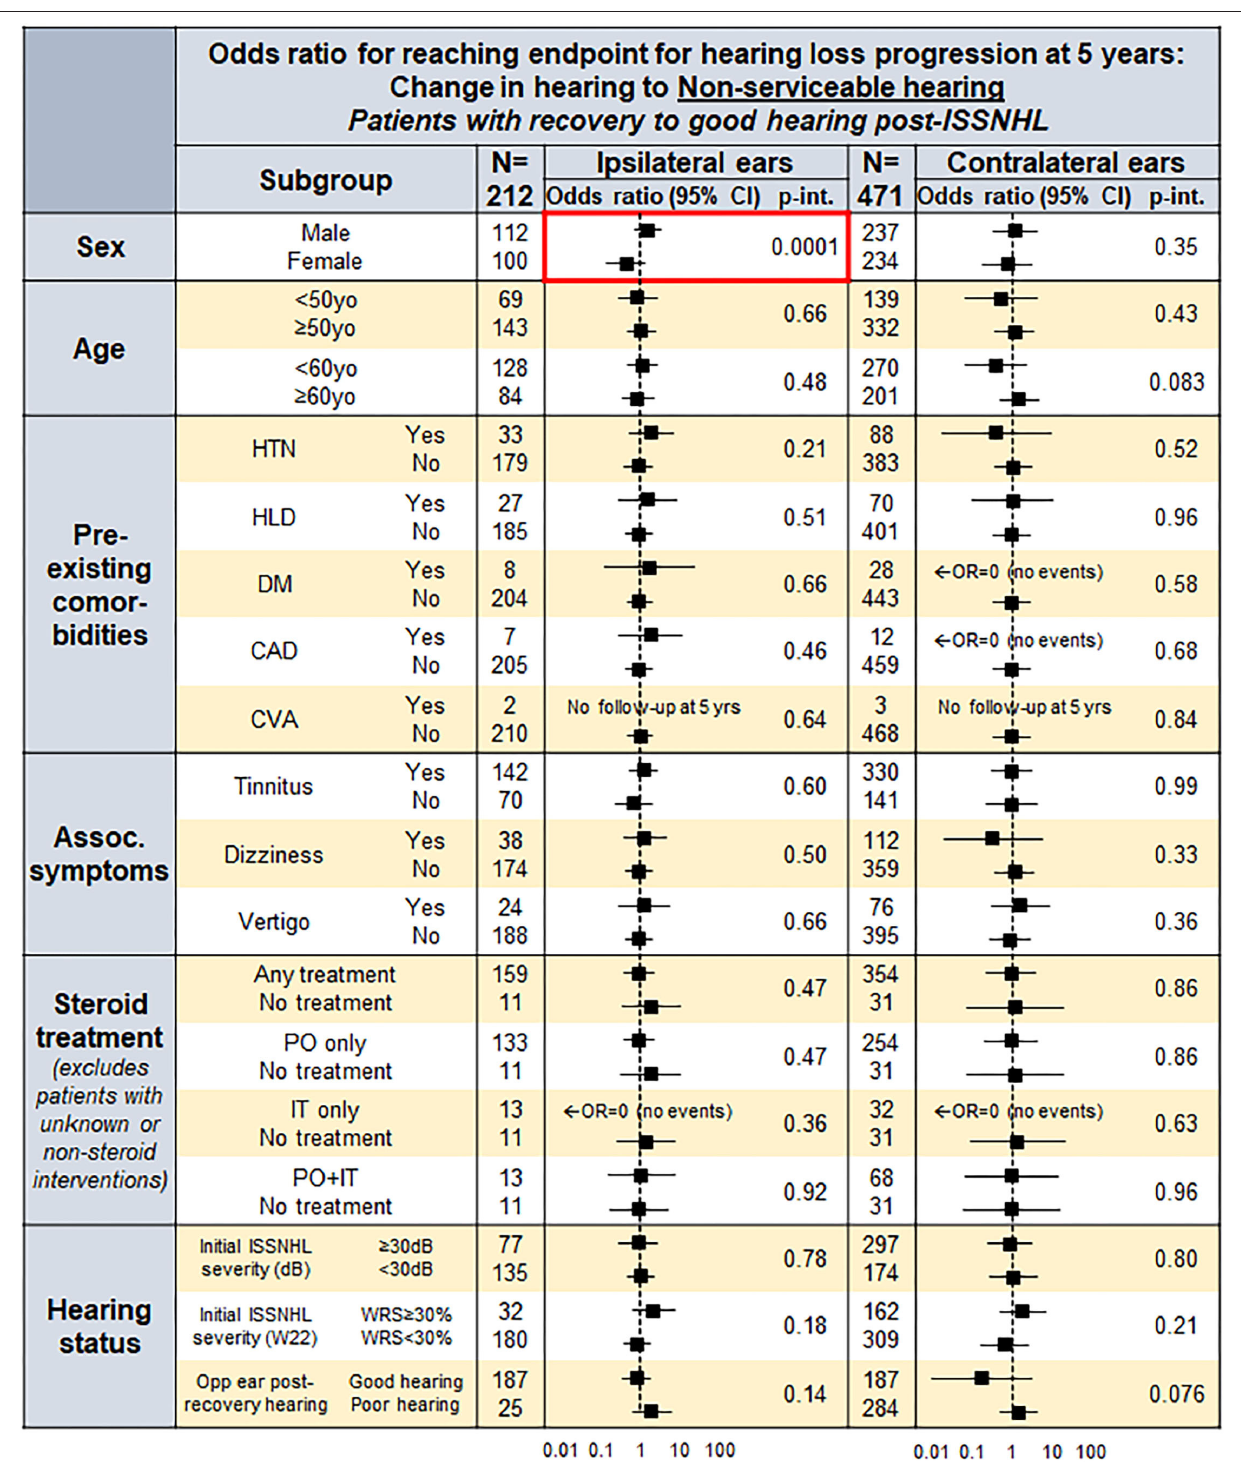
Frontiers in Neurology |